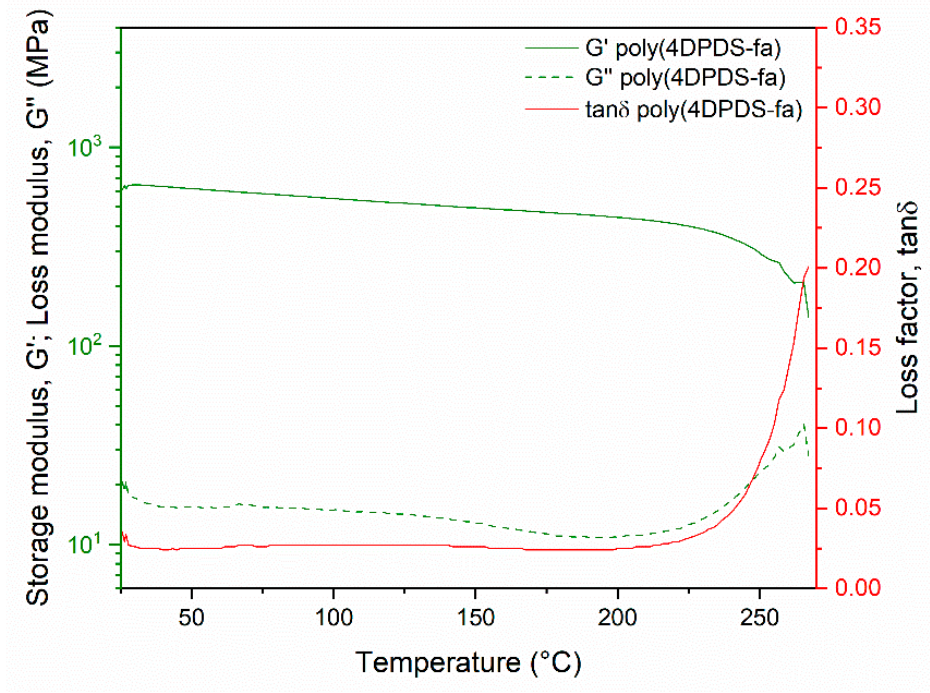
Figure A20. Rheology temperature sweep curves in torsion mode of poly(4DPDS-fa).